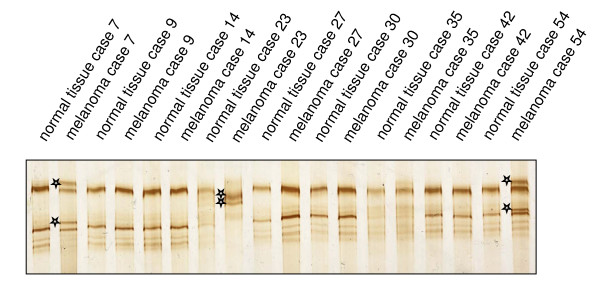
PCR-SSCP analysis of B-raf exon 15 in resection specimens from cutaneous/subcutaneous melanoma metastases. Cases 7, 23, and 54 exhibit different DNA fragment mobilities when compared to the respective normal tissues from patients. Suspecting these tumour specimens to harbour mutations, these samples were subjected to DNA sequencing.